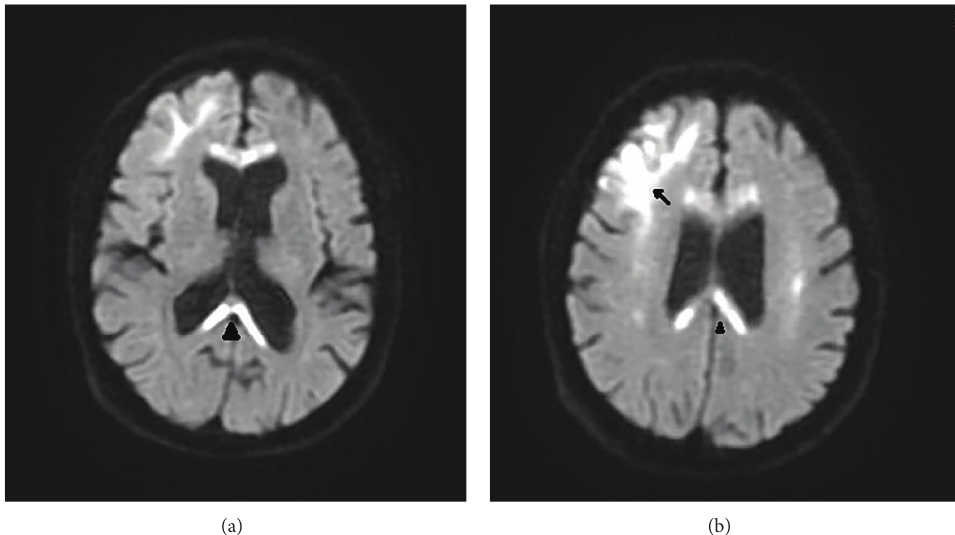
Figure 4: Diffusion weighted images displaying restricted diffusion involving the subcortical right frontal white matter (black arrow) and genu and splenium (black arrowhead) of corpus callosum.